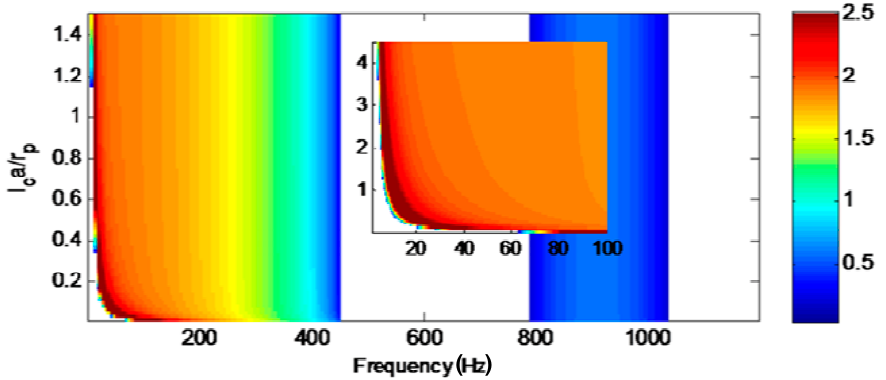
Figure 7. Imaginary parts of μ , as functions of l ca , for the periodic pipe of which its HR chambers are filled with air and water.